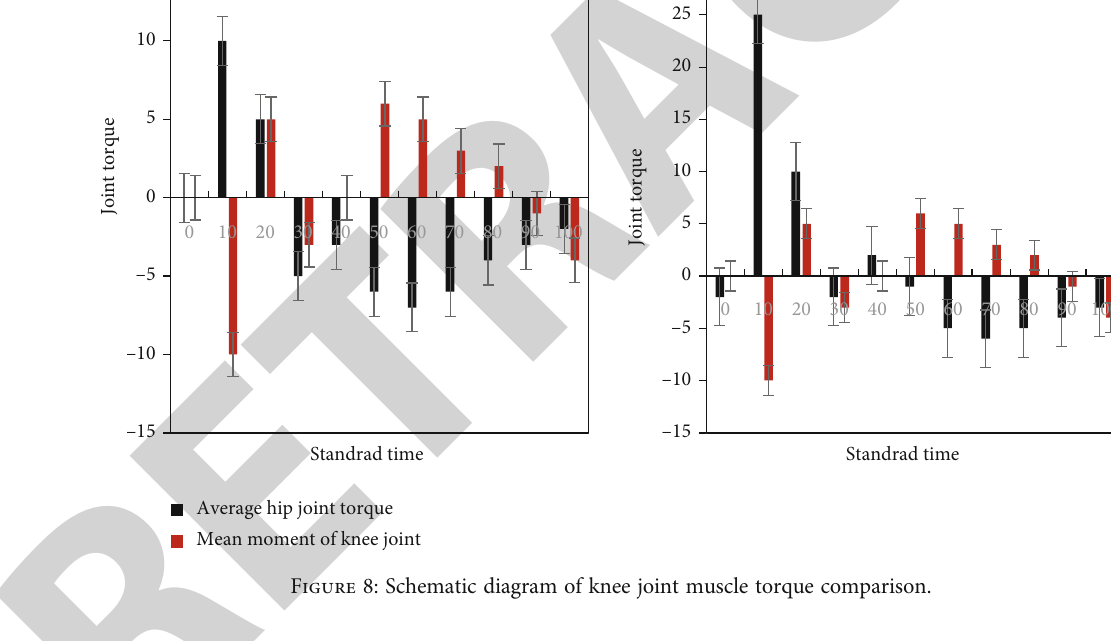
Figure 8: Schematic diagram of knee joint muscle torque